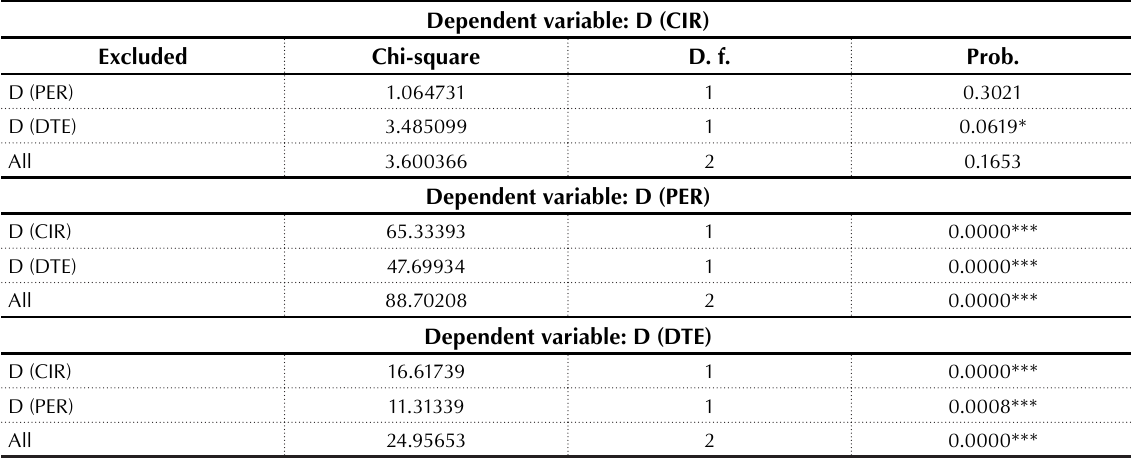
Source: researcher’s computation (2017).